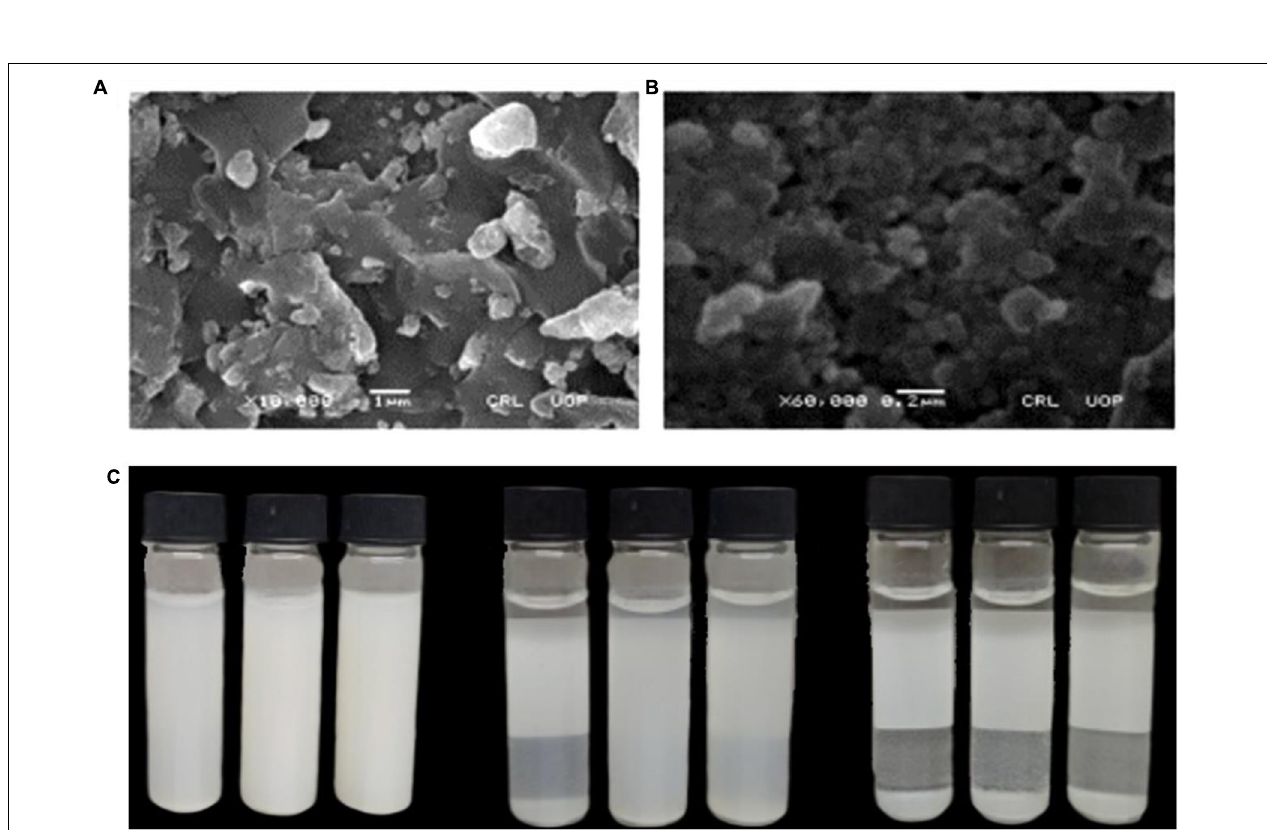
FIGURE 4 | Typical SEM micrograph of ZnO-NPs (A) at 1 µ m and (B) at 200 nm. (C) Pictorial presentation of dispersion studies of ZnO-NPs at varied pH as a function of storage time.